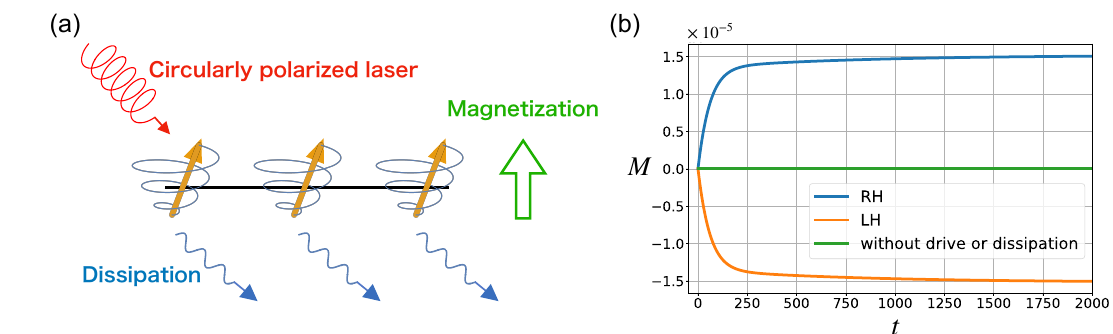
Figure 11: (a) Illustration of inverse Faraday effect in the presence of dissipation. (b) Time evolution of magnetization along z -axis. The blue (orange) line shows a result for a right (left)-handed circularly polarized laser. The parameters are B = 0.1, ω = ± 5, β = 10, Λ = 5, and L =